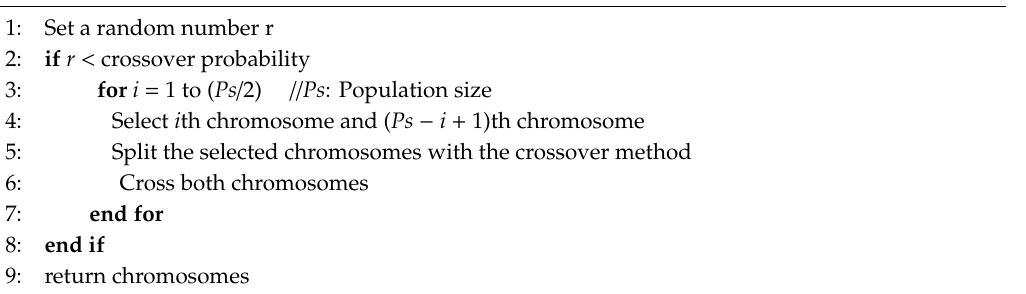
Algorithm 2. Pseudocode for crossover operation in MSGA. Algorithm 2 Pseudocode for crossover operation in MSGA. Algorithm 2 Pseudocode for crossover operation in MSGA.